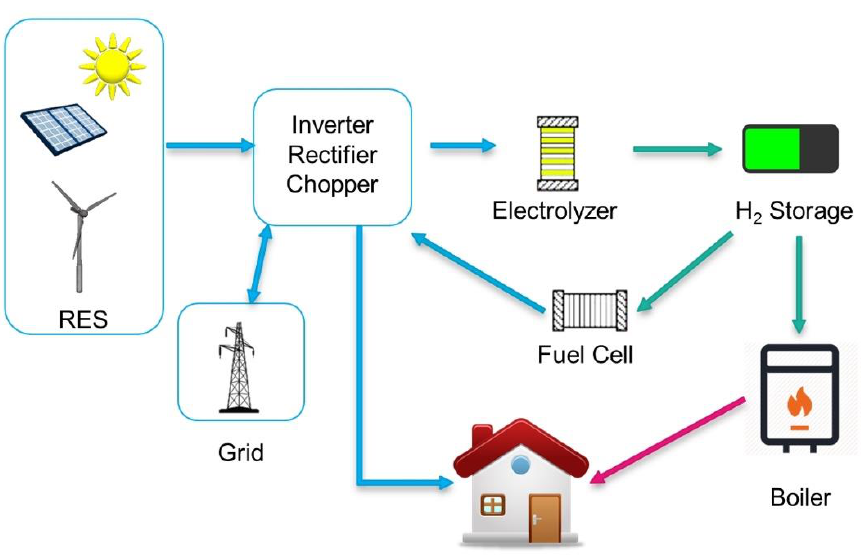
Figure 1. A possible scheme of production of hydrogen and its use in hydrogen economy.